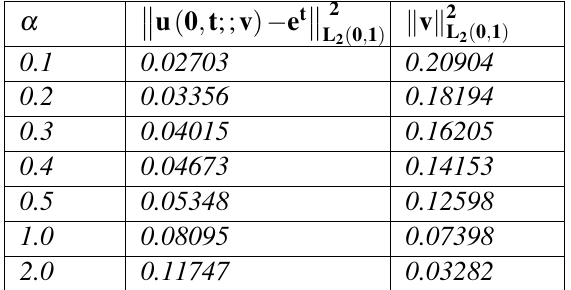
(cid:107) 2 and (cid:107) v ) − e t (cid:107) 2 100 100 L 2 ( 0 , 1 ) L 2 ( 0 , 1 )